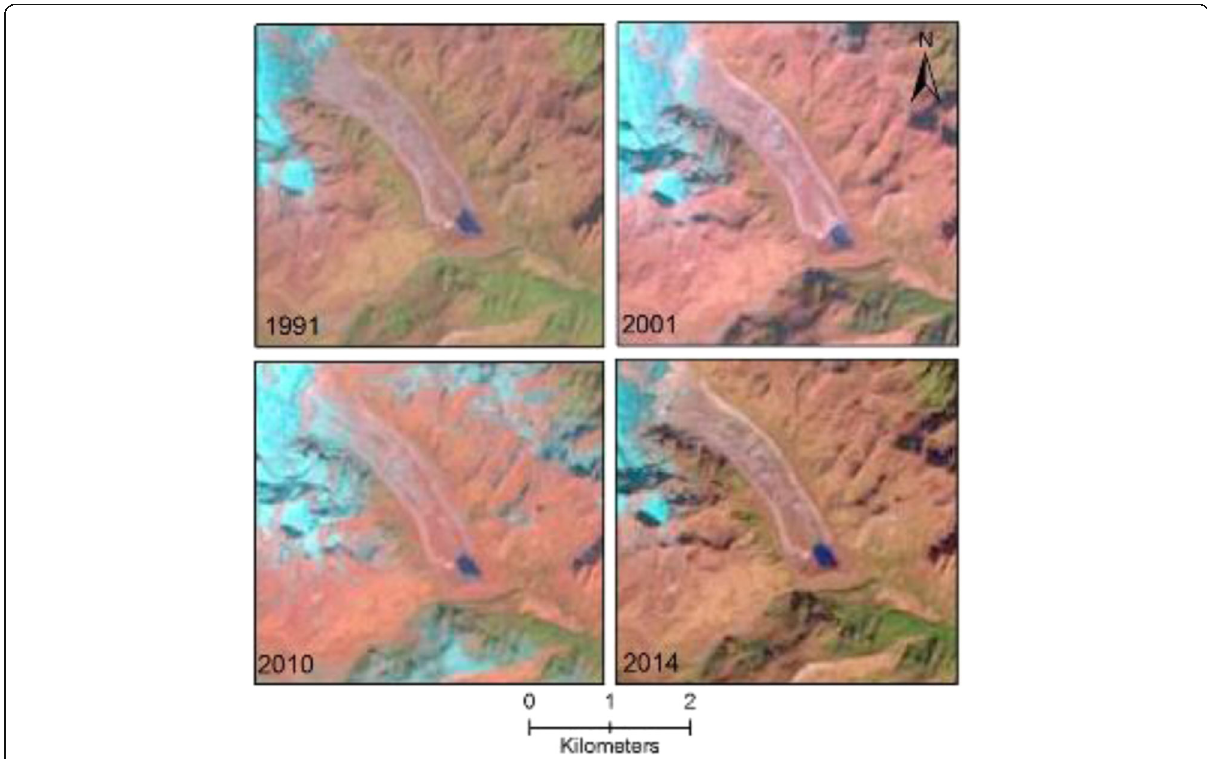
Fig. 3 Time series Landsat images showing growth progression of Lemthang